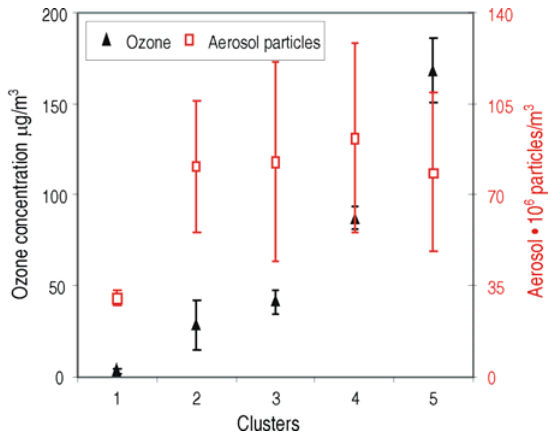
Fig. 2. Statistical analysis of ozone concentration and aerosol particle numerical concentration during experi- ment. The horizontal lines in the boxes denote the 25 th th , and 75 percentile values. The error bars denote the 50 th th 5 and 95 percentile values. The triangles indicate the th 99 percentile values and the stars denote the maximum values. The squares in the boxes denote the average of the ozone or aerosol concentrations